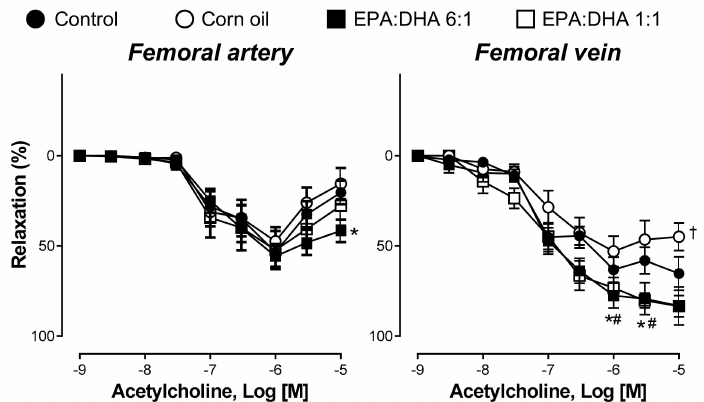
Figure 1. Oral intake of eicosapentaenoic acid (EPA):docosahexaenoic acid (DHA) 6:1 by middle-aged rats improved the endothelial function of the femoral artery and vein. Rings were precontracted with serotonin (5-HT, 1 µ M) before the construction of a concentration–relaxation curve to acetylcholine. Results are expressed as percentage of relaxation and given as means ± S.E.M. of ten rats per group. * p < 0.05 for EPA:DHA 6:1 vs. control, # p < 0.05 for EPA:DHA 1:1 vs. control, and † p < 0.05 for corn oil vs.